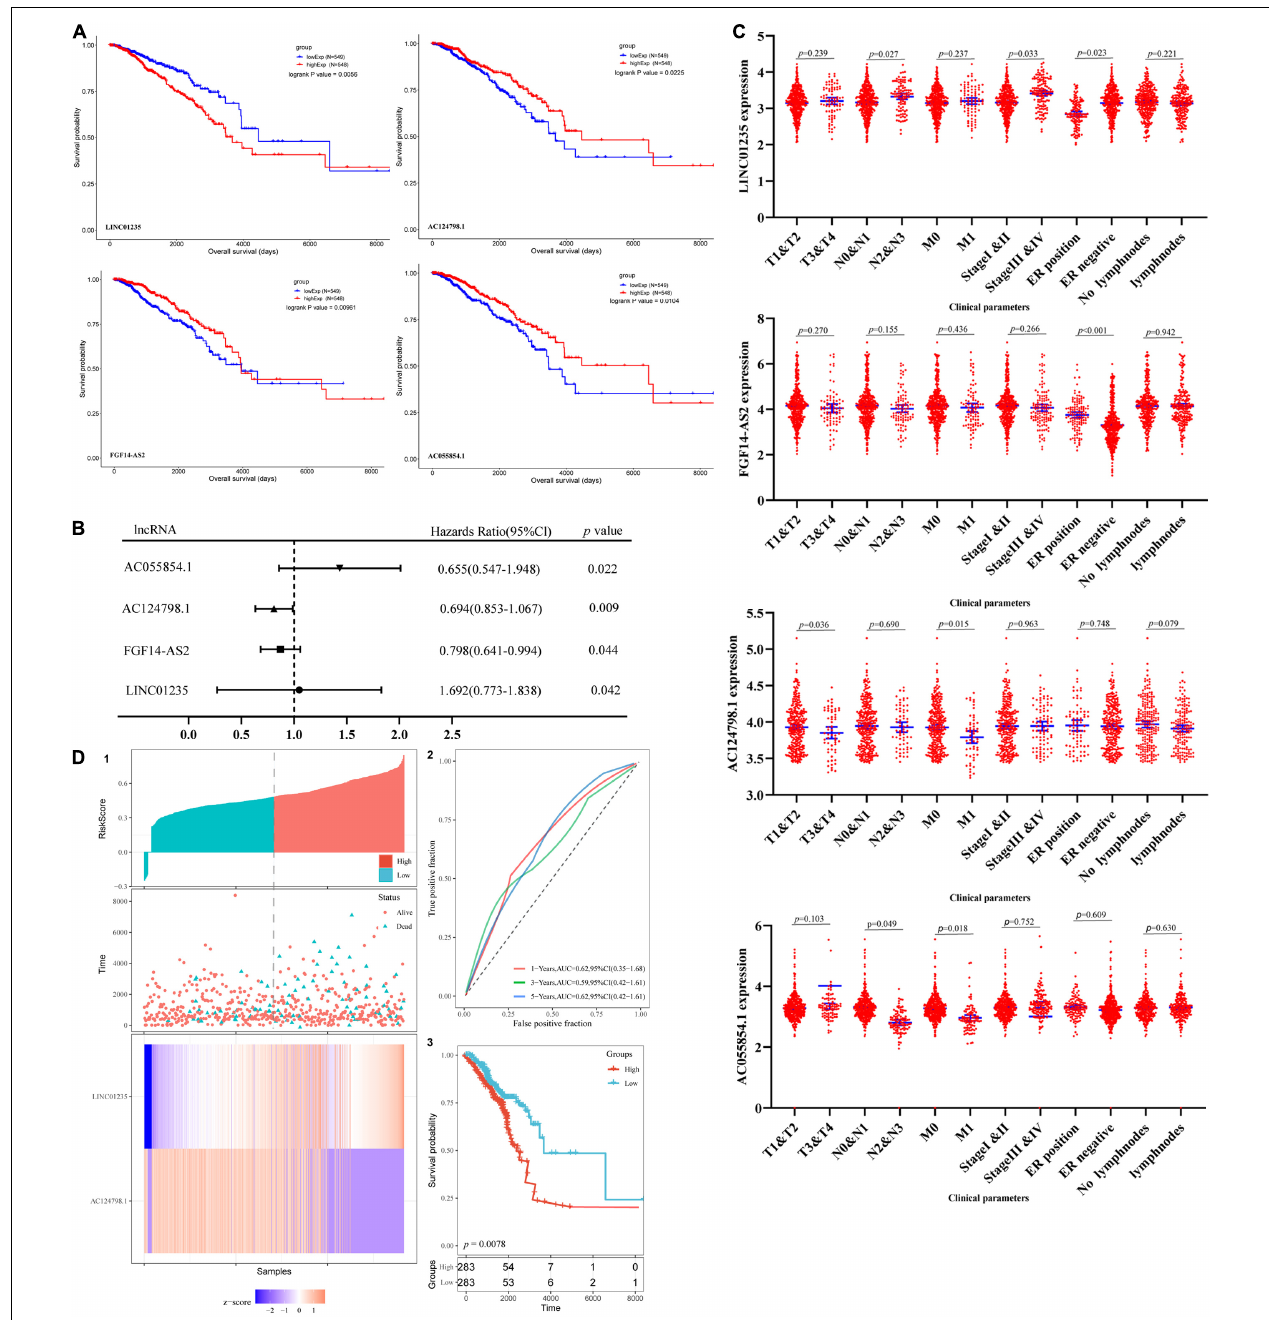
FIGURE 2 | (A) Kaplan–Meier (K–M) analysis results of LINC01235, AC055854.1, FGF14-AS2, and AC124798.1, the four lncRNAs found to be associated with the prognosis of breast cancer. (B) Univariate Cox proportional hazards regression analysis of LINC01235, AC055854.1, FGF14-AS2, and AC124798.1 in breast cancer. (C) Correlation analysis of the expression of LINC01235, AC055854.1, FGF14-AS2, and AC124798.1 with clinicopathological parameters. (D) Prognostic risk score model analysis of LINC01235 and AC124798.1 in breast cancer patients. (1) Risk score distribution, patient survival status distribution, and heatmap of P LINC01235 and AC124798.1 expression by risk score. (2) The ROC curves for predicting survival in breast cancer patients by the risk score. (3) Kaplan–Meier curves for high-risk and low-risk groups.